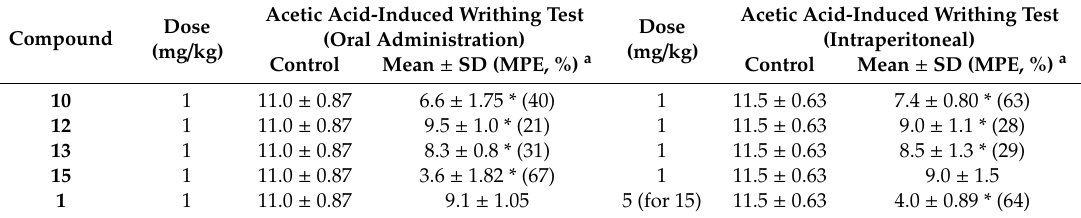
Table 2. Analgesic activity of compounds 1 , 10 , 12 , 13 , 15 in acetic acid-induced writhing test with various administration routes. Compound